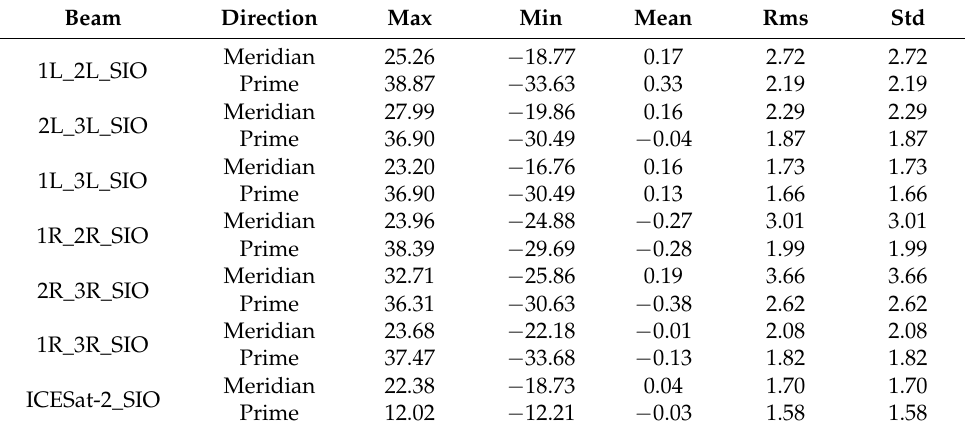
Table 14. Statistics of differences between gridded DOVs calculated by the cross-beam DOVs and the SIO V31.1-DOV model (Unit: